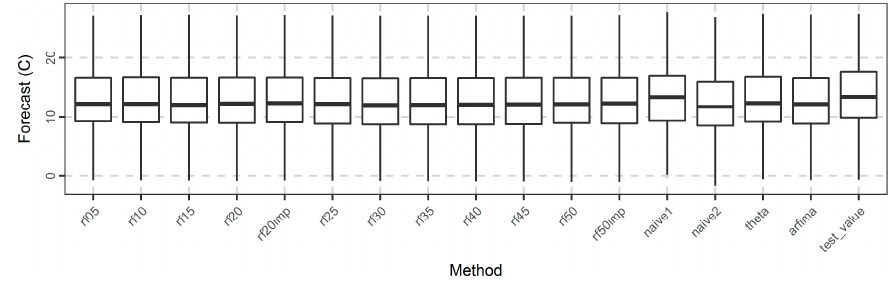
Figure 13. Boxplot of forecasts of temperature for each method.